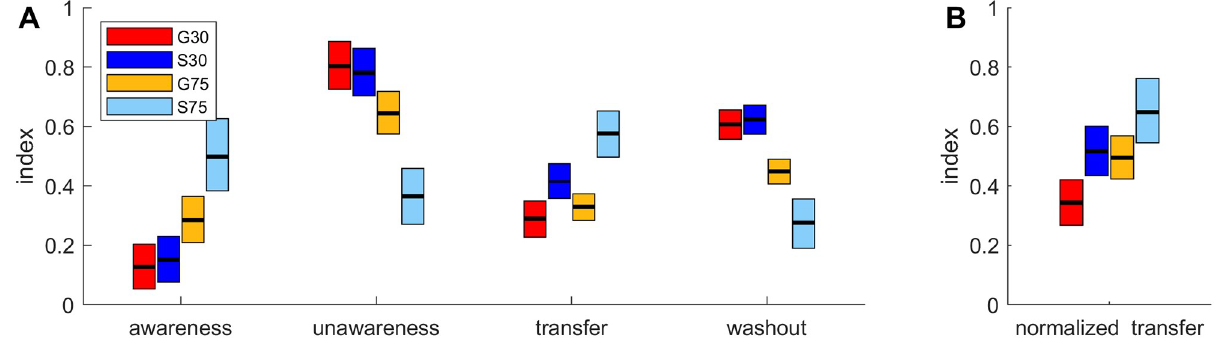
Fig 4. Awareness, unawareness, intermanual transfer and washout. Group means and their HDIs of posterior probability distributions for awareness, unawareness, intermanual transfer and washout indices (A) as well as for normalized intermanual transfer (B).